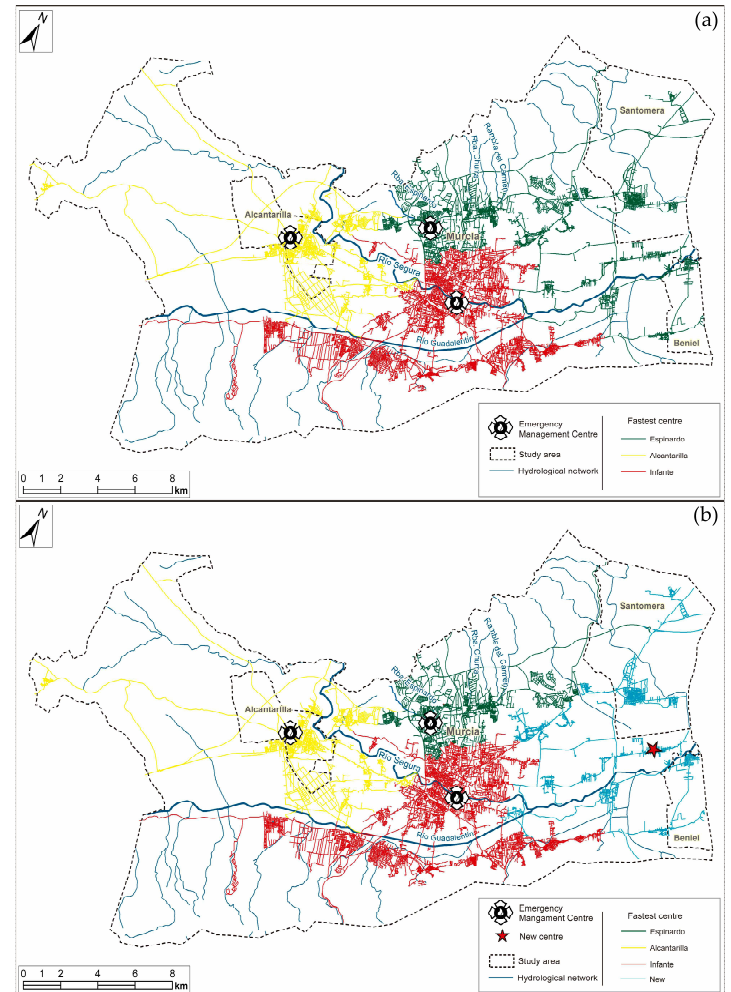
Figure 9. ( a ) Map of the service areas in the current vulnerability network and ( b ) with the new